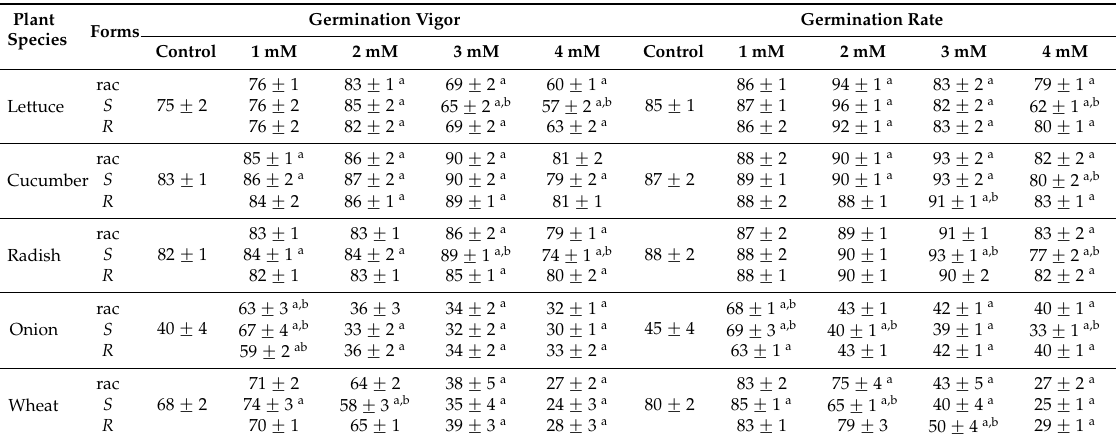
Table 1. Effect of rac-4,8-DHT, S -(+)-isosclerone, and R -( ´ )-regiolone at different concentrations on seed germination of five plant